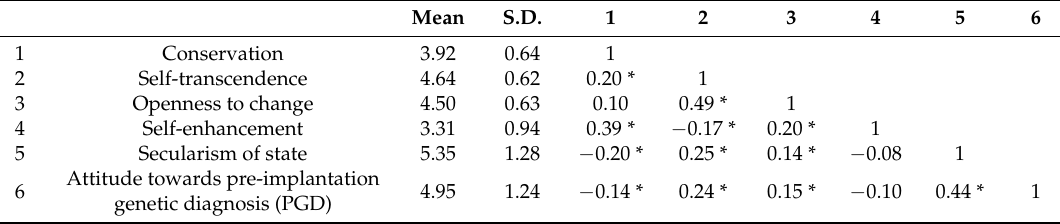
Table 1. Means, standard deviations, and